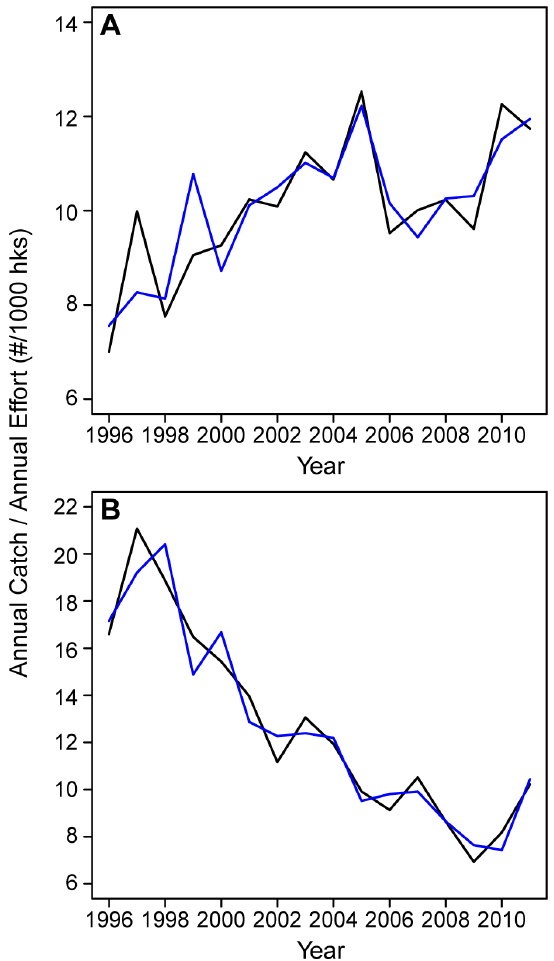
Figure 1. The annual observer and generalized additive model CPUE ( # fish per 1000 hooks). Panels indicate ( A ) fishes , 15 kg and ( B ) fishes $ 15 kg. In both panels black line represents CPUE from observer data, blue line represents CPUE estimated from the generalized additive model.